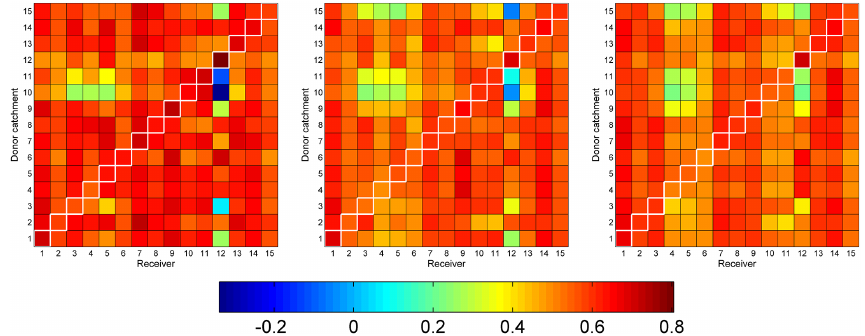
Figure 4. Color-coded matrices for the mean NS model performance of the parameter transfer for the validation period for the selected 15 catchments.